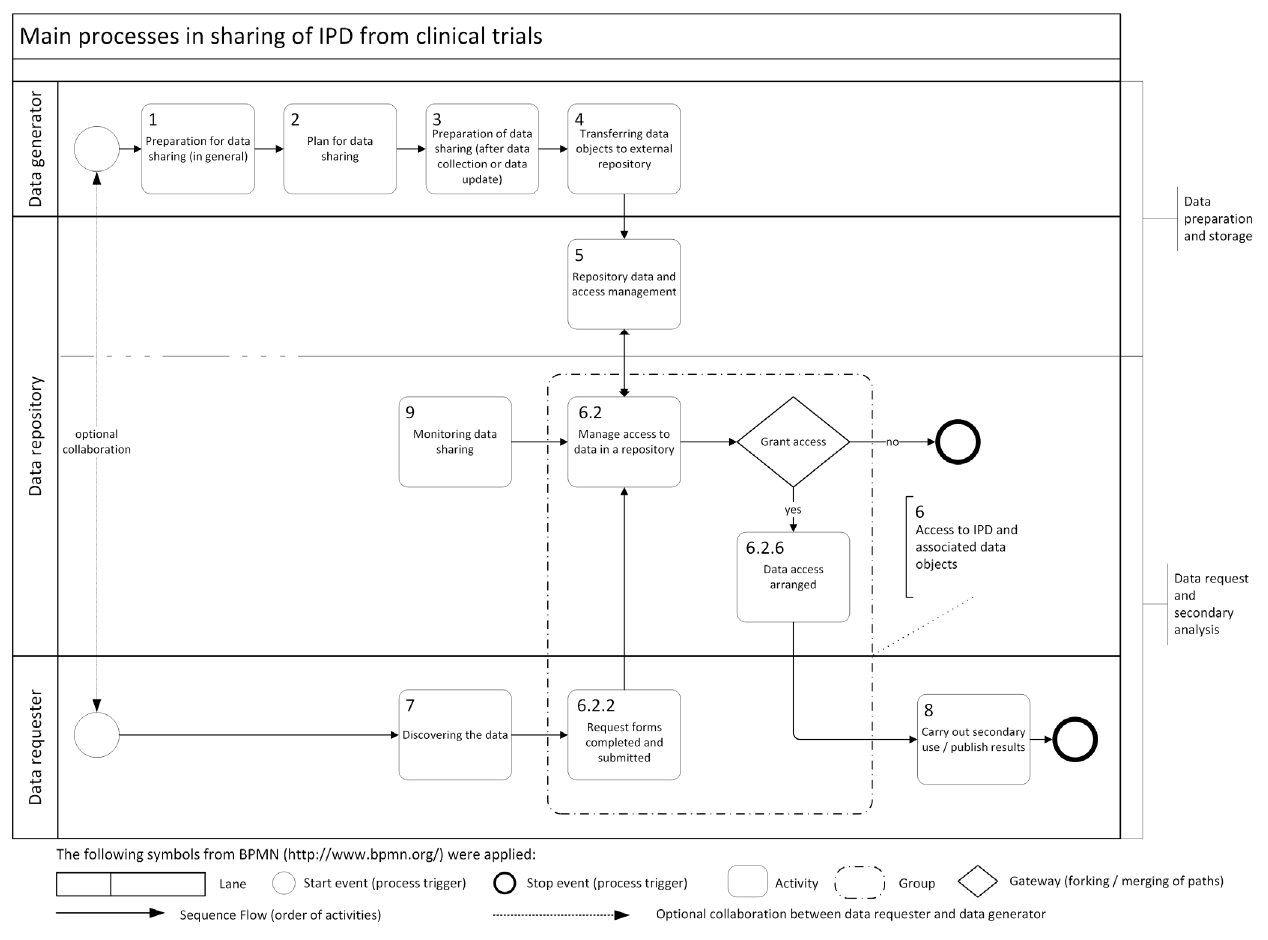
Figure 1. Overview on the main processes in sharing of